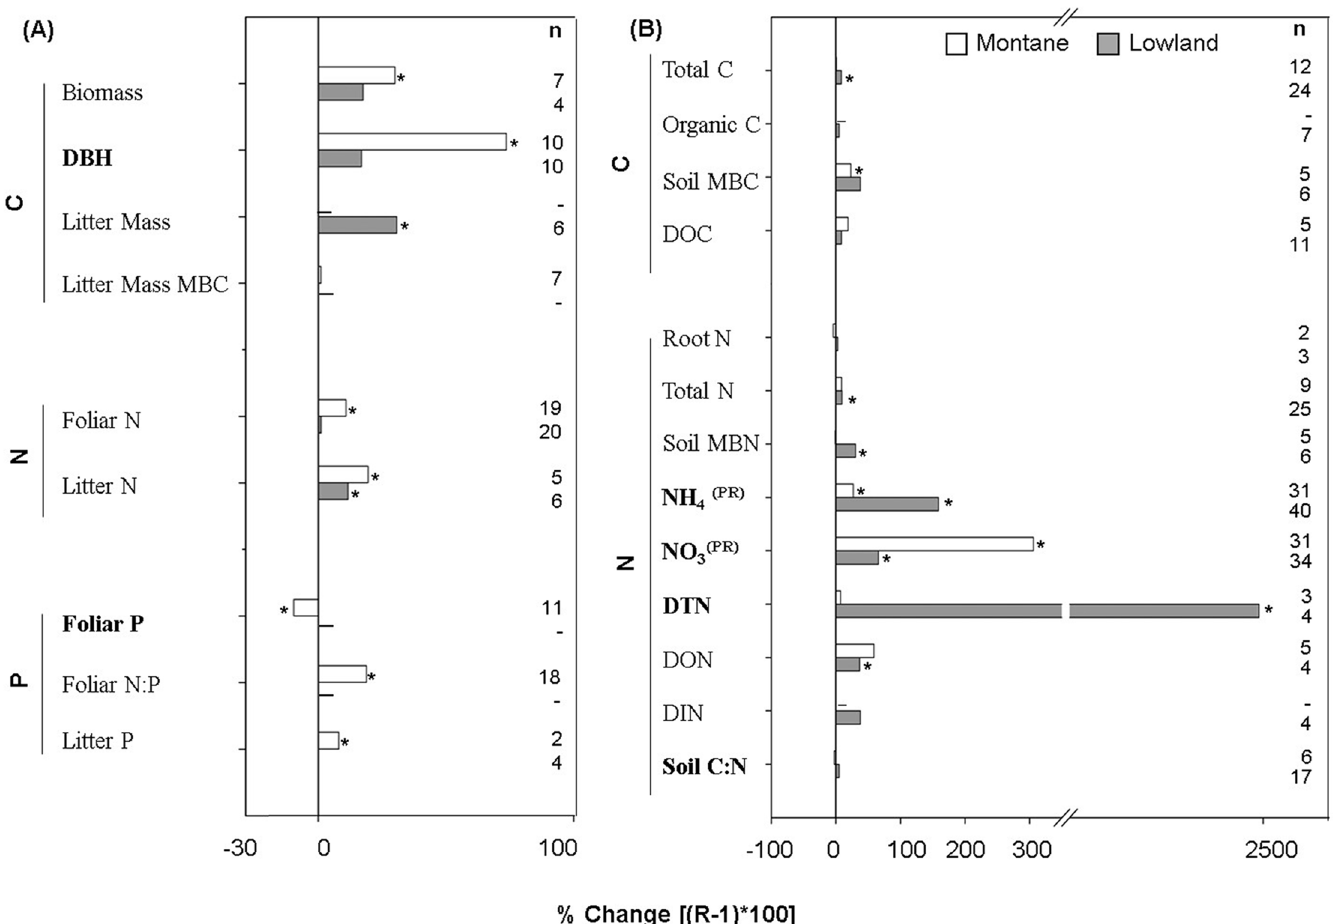
Fig 3. Percentage of change for response pools in (A) aboveground and (B) belowground variables. An asterisk represents significant percentage of change with the N addition. A PR superscript represent a significantly different change between montane and lowland forests (ProRand (cid:3) 0.05). Bolded variables represent significant associated total heterogeneity (Qt; p (cid:3) 0.05). n represent the number of pair comparison between control and experimental N-